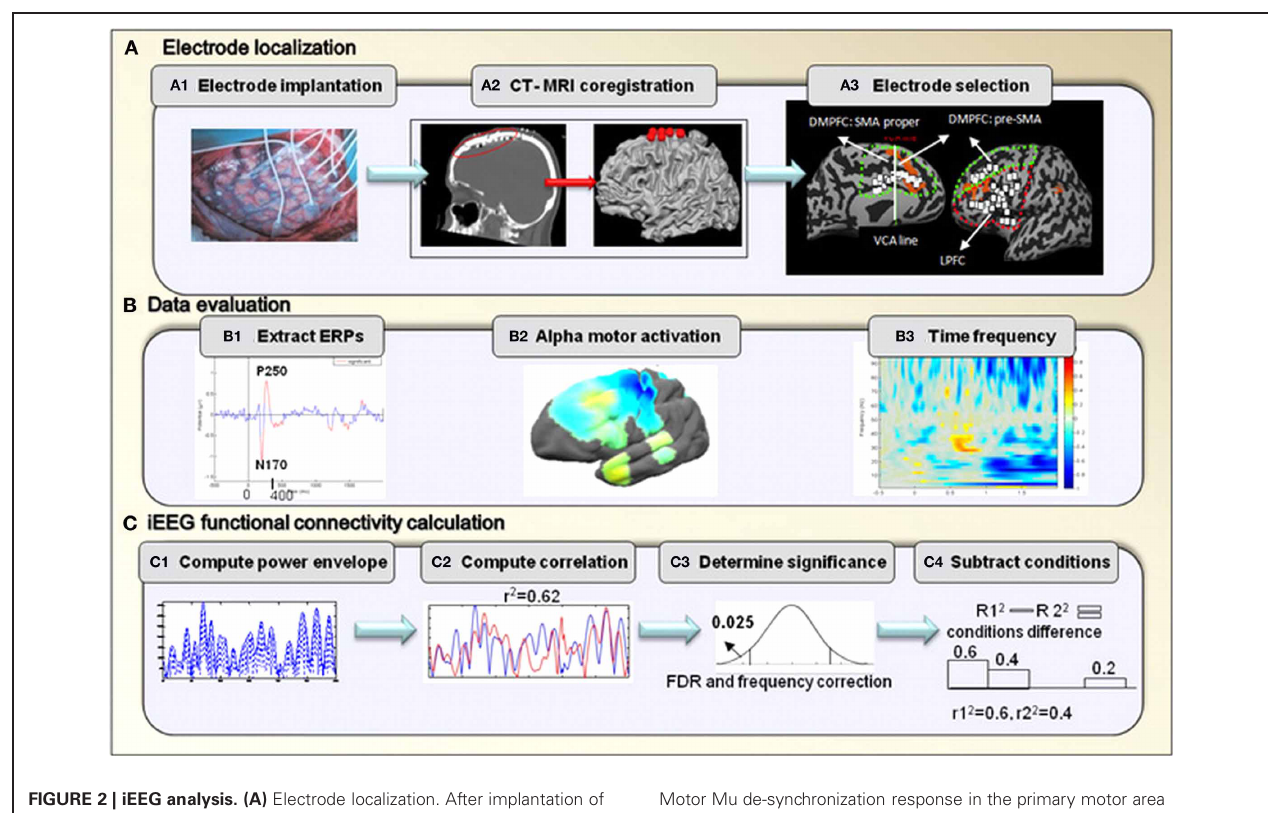
FIGURE 2 | iEEG analysis. (A) Electrode localization. After implantation of electrodes, CT scan was performed to verify electrode location, and was coregistered with pre-operative MRI T1-SPGR images. Data was then evaluated for visual response in posterior temporal electrodes, an example is shown of ERPs response from one patient (#2) (B1) .